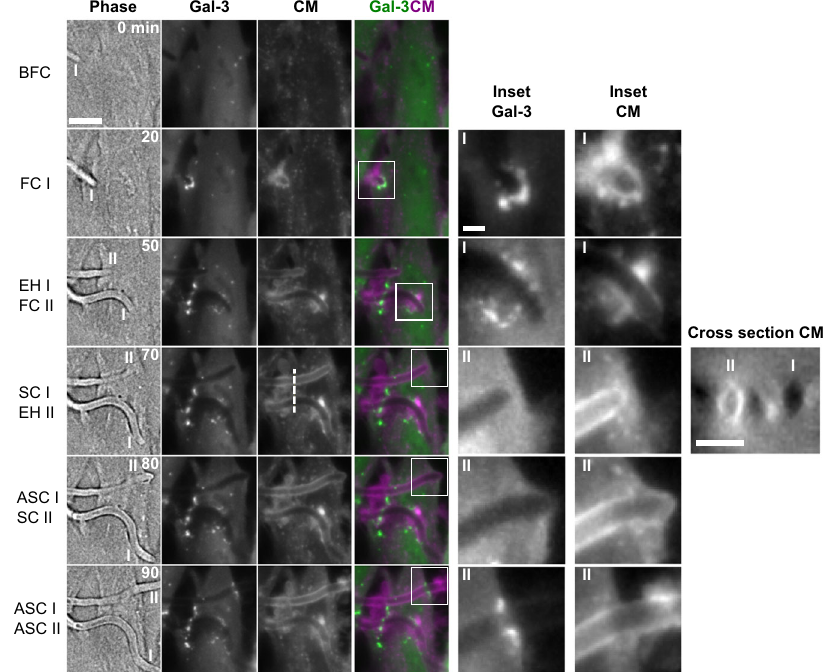
Fig. 2 High-resolution live-cell imaging of two C. albicans hyphae invading a single HeLa cell via a ‘ multiple sites ’ scenario and an ‘ exit site ’ scenario. Six time points are presented, with the invasion stages de fi ned in Fig. 1 corresponding to either fi lament I ( ‘ multiple sites ’ scenario) or II ( ‘ exit site ’ scenario). For each time point a phase image is presented together with a maximum intensity projection of three z-sections in the Gal-3 and CellMask (CM) channels, and a composite image showing Gal-3 (green) and CM (magenta) together. Two insets (Gal-3 and CM) are presented for each timepoint, corresponding to fi lament I or II. A cross-section in the CM channel through both fi laments (dotted line) is presented at time point 70 min. A circular CM organization is observed around fi lament II but not fi lament I. No host cell death was observed during the course of live-cell imaging. Scale bars are 10 µ m, 2 µ m (inset) and 5 µ m (cross-section). For other invasion scenarios see Supplementary Fig.